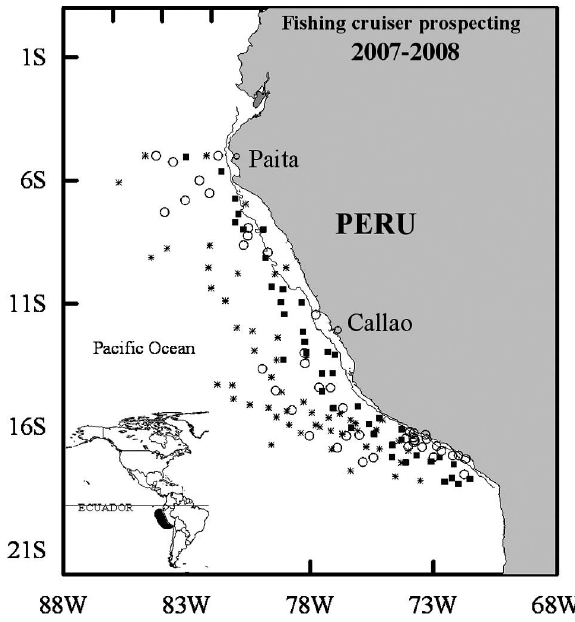
Fig . 1. – Pacific Ocean off Peru, principal area of jumbo squid fish- ing in the Humboldt Current System (Fishing cruiser prospecting: – .March 2007, *June-July 2008 and, O November-December